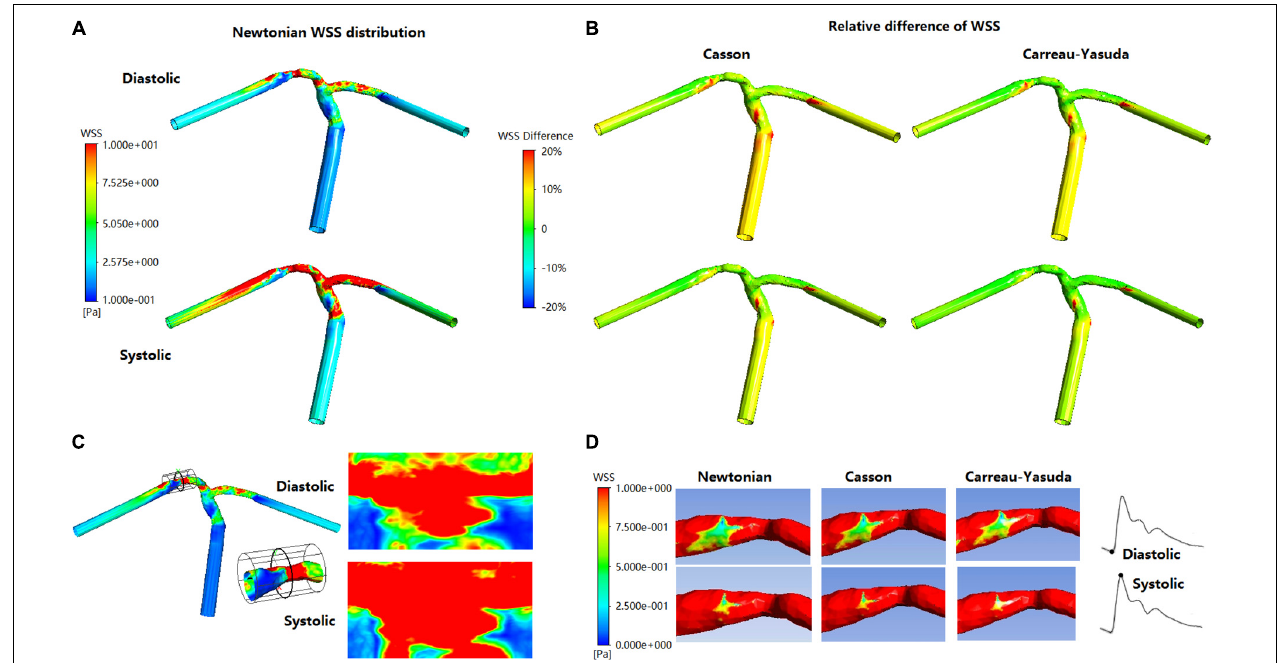
FIGURE 5 | The distribution of WSS at end of diastole and systolic peak in Newtonian, Casson, and Carreau-Yasuda models. (A) WSS distribution in Newtonian model. (B) The relative difference between non-Newtonian (Casson/Carreau-Yasuda) and Newtonian models. (C) The expansion (cylindrical projection) of stenosis WSS distribution in Newtonian model. The scale is identical with panel (A) . (D) The stenotic region was enlarged in the low panel to reveal the low-WSS areas (red areas were those with WSS > 1 Pa). TABLE 2 | Maximum and minimum WSS values in a MCA stenosis model with Newtonian and non-Newtonian assumptions in transient CFD simulation. Systolic Diastolic Newtonian Casson Carreau-Yasuda Newtonian Casson Carreau-Yasuda Max WSS Min